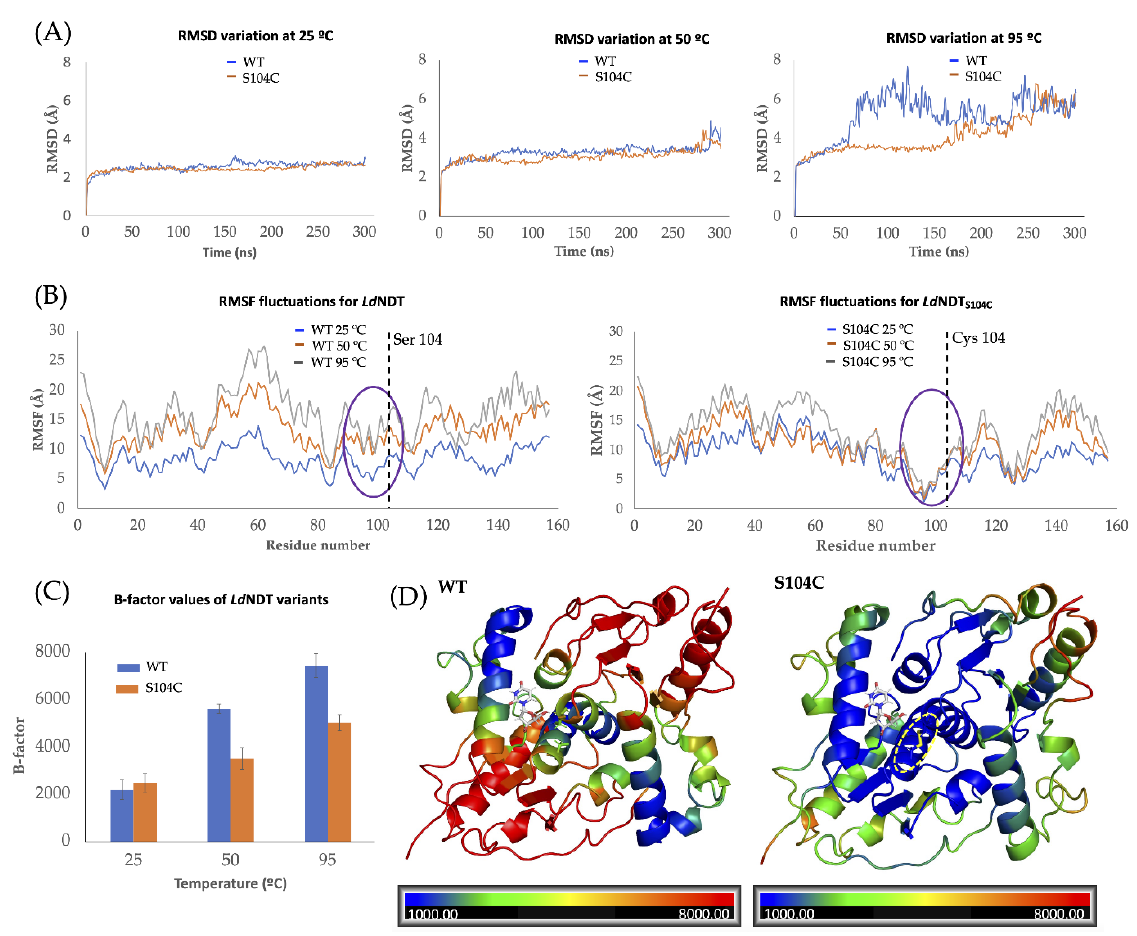
Figure 5. ( A ) RMSD variation of wild-type Ld NDT and Ld ND S104C at 25 °C (left), 50 °C (center), and 95 °C (right). ( B ) Residue-by-residue RMSF fluctuations for Ld NDT (left) and Ld NDT S104C (right) through MD simulations at different temperatures. A purple circle indicates amino acids present in the vicinity of catalytic Glu98, while the dashed line indicates the 104 positions. ( C ) Average B-factor values for Ld NDT and Ld NDT S104C at different temperatures. ( D ) Cartoon representation of Ld NDT (left) and Ld NDT S104C (right) colored according to the B-factor values calculated at 95 °C.